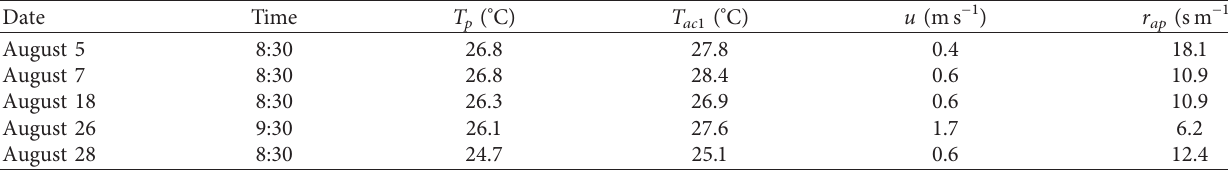
Table 3: r ap in the rice paddy field.